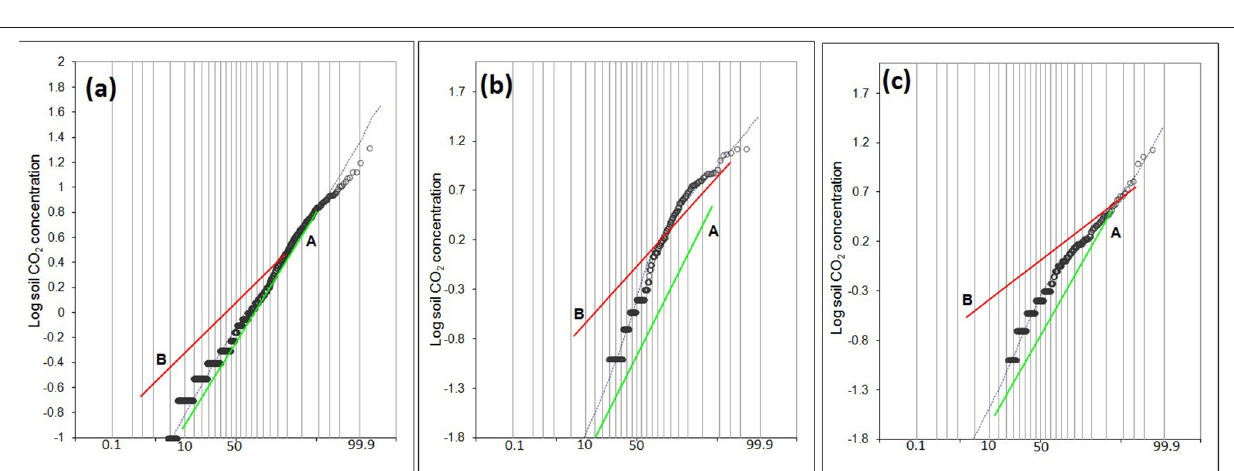
FIGURE 8 | E-type soil CO 2 concentration map for São Jorge Island (cell size = 50 × 50 m; interpolation method: sGs). Numbers SJ1–SJ4 represent the DDS identified at São Jorge Island (highlighted as orange and red colors) (UTM(m)-WGS84, zone 26S). The red dotted line represents a degassing lineament. Blue letters represent tectonic structures mentioned in the text: PC, Pico do Carvão; RS, Ribeira Seca; USJ, Urze-S. João.